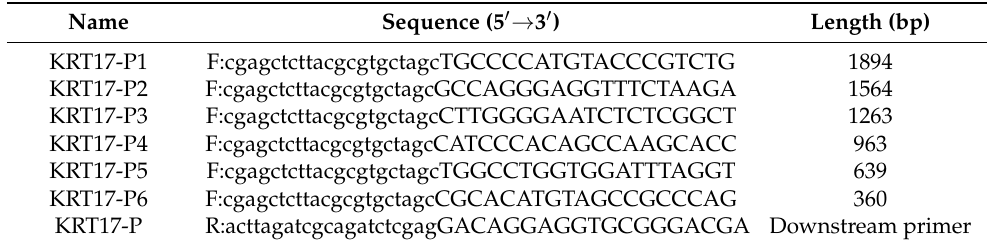
Table 13. Primers of KRT17 promoter for the construction of deletion plasmids.